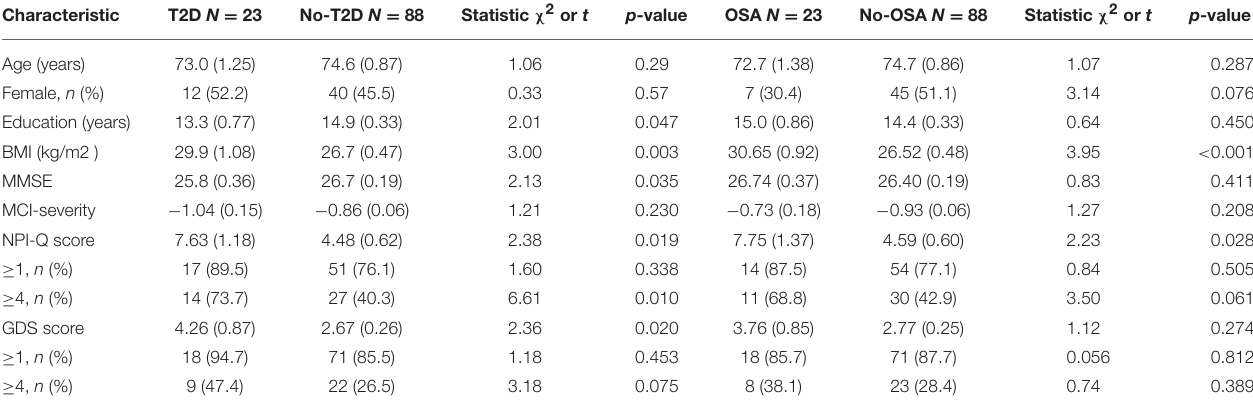
TABLE 3 | Demographic, cognitive, and behavioral measures of T2D and OSA groups.